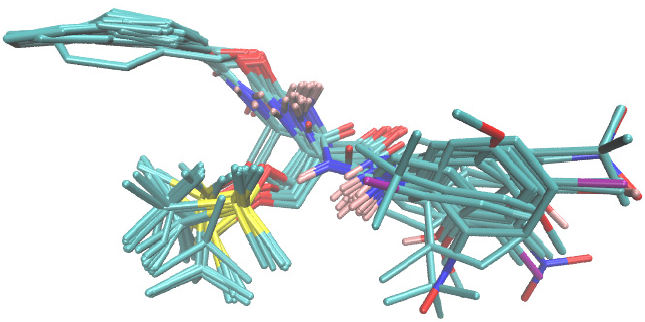
Figure 7. Docking-driven alignment of BChE silicon-based inhibitors in the enzyme active site AC2.